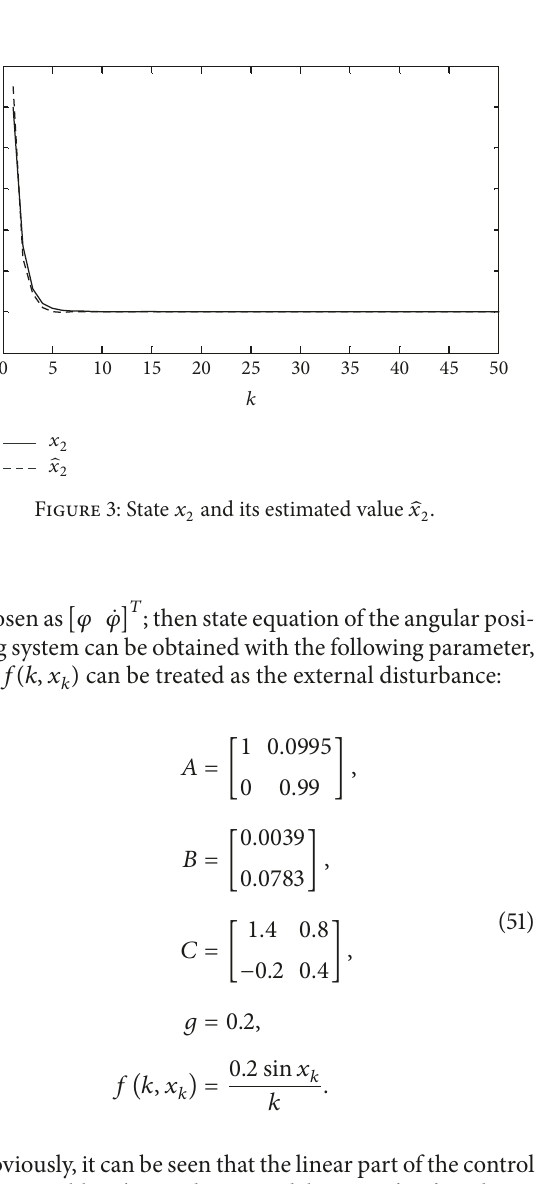
Figure 2: State 𝑥 1 and its estimated value ̂𝑥 1 .